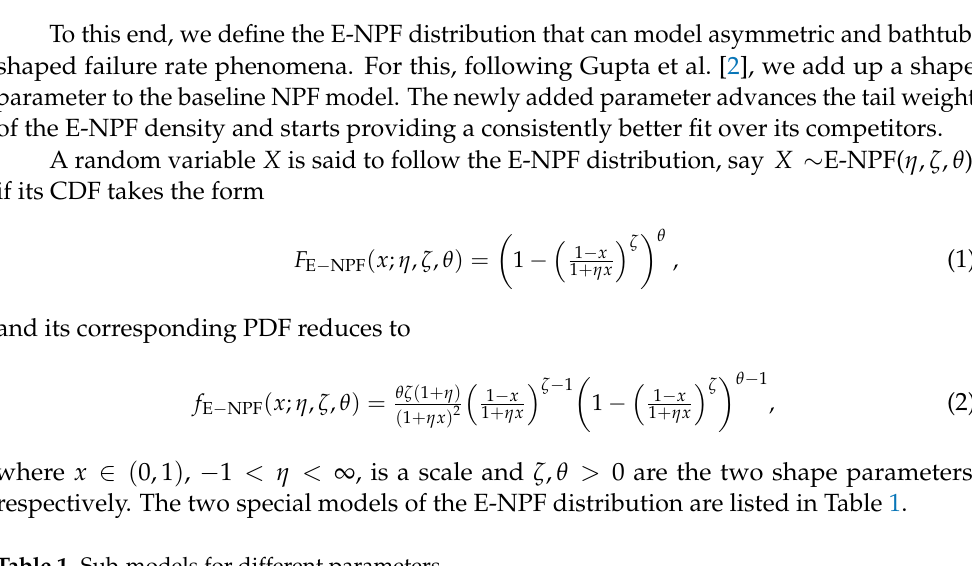
Table 1. Sub-models for different parameters.